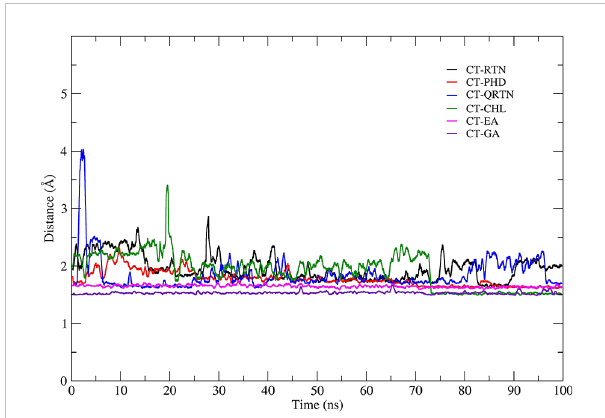
FIGURE 7 The variations in the minimum distance observed between the GM1 binding pocket (chain F) with the six phytochemicals during the simulation.